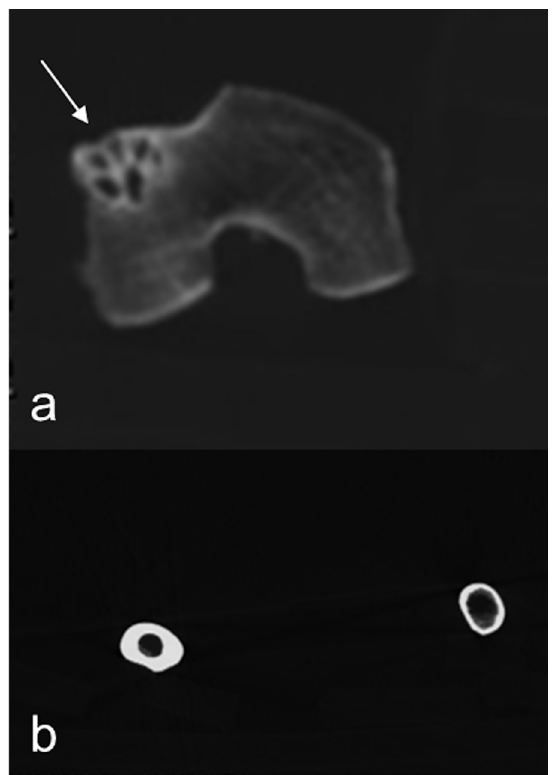
doi:10.1371/journal.pone.0154349.g006